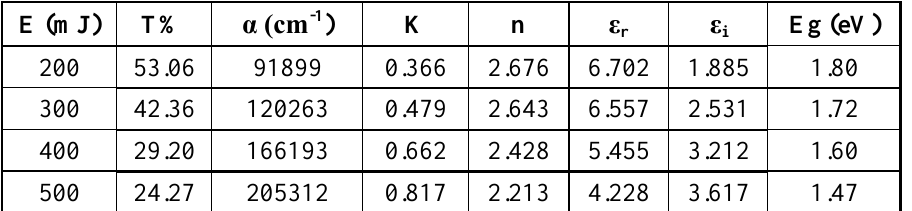
Table 3: The optical parameters of PbS nanostructures for different laser energies at wavelength λ = 500 nm and thickness t=200